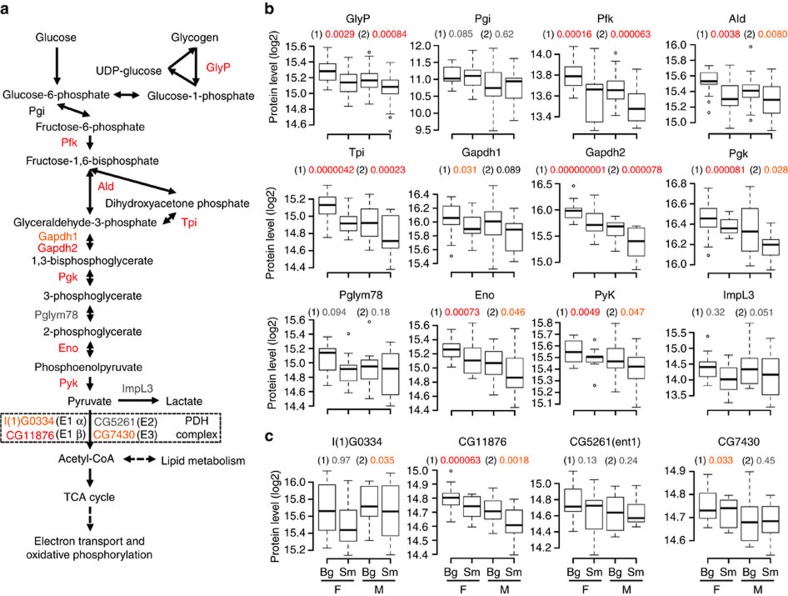
Systemic association of glucose metabolism with wing size.(a) Pathway map for glucose metabolism. Proteins detected by SWATH-MS are shown. Proteins in red indicates association with either of absolute or relative CS at 5% FDR. Proteins in orange indicates association at nominal P-value <0.05. (b) Glycolytic protein levels plotted against wing size for each sex. P-values are shown for association with absolute CS (1) and relative CS (2). Significance levels of association are indicated by colour of P-values as in a. Bg, big wing samples; F, female; M, male; Sm, small wing samples. (c) Subunit proteins from pyruvate dehydrogenase (PDH) complex are plotted against wing size for each sex.